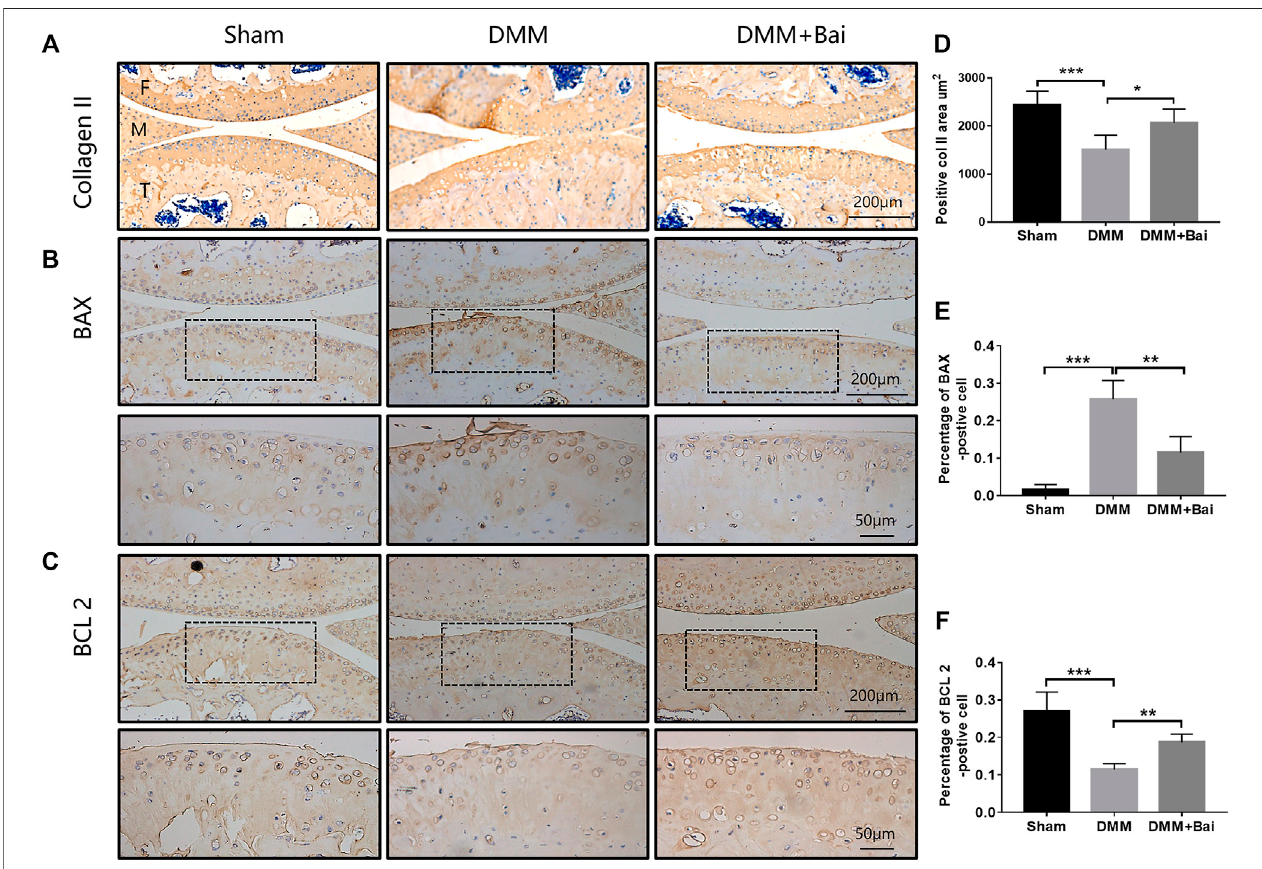
FIGURE5| Baiinhibitschondrocyte apoptosisand increases collagenII. (A – C) ImmunohistochemicalstainingofcollagenII,BAX, andBCL2ineach group. (D – F) Quantitative analysis of collagen II, BAX, and BCL 2. Data are shown as the mean ± SD. * p < 0.05, ** p < 0.01, *** p < 0.001 vs. the DMM group, n (cid:1) 5. F: Femur, M: Meniscus, T: